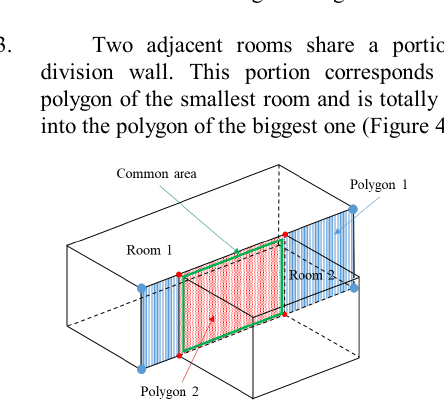
Figure 4. Case 3: Both rooms share a common surface which corresponds with the polygon of the smallest room 4. Two adjacent rooms share a portion of the division wall. Neither polygon of the rooms is contained in another (Figure